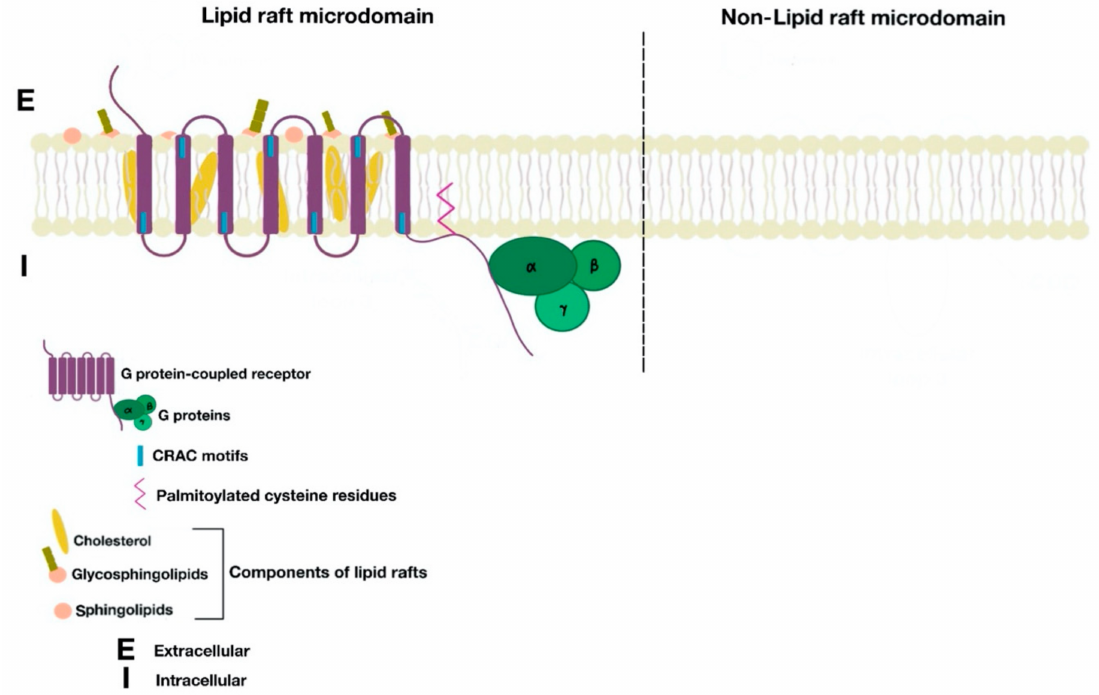
Figure 1. Cell membrane partitions into lipid raft and non-lipid raft